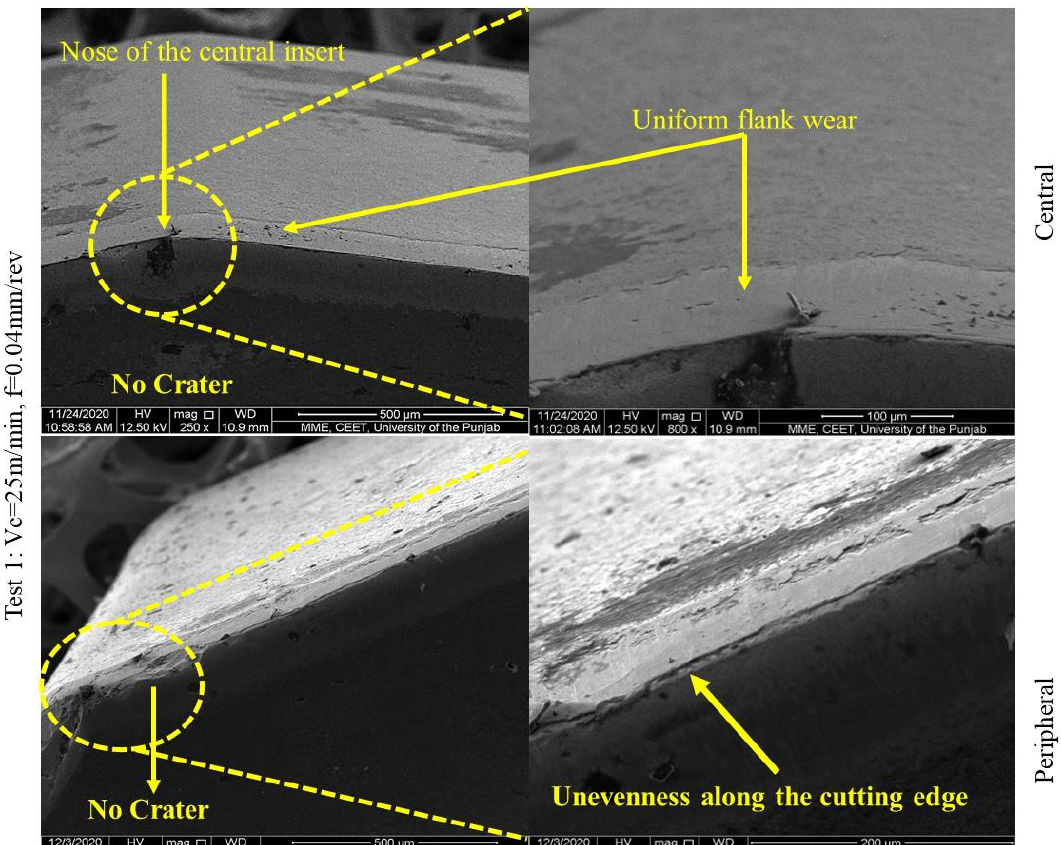
Figure 15. Wiper and central insert tool wear progression experiment 1.